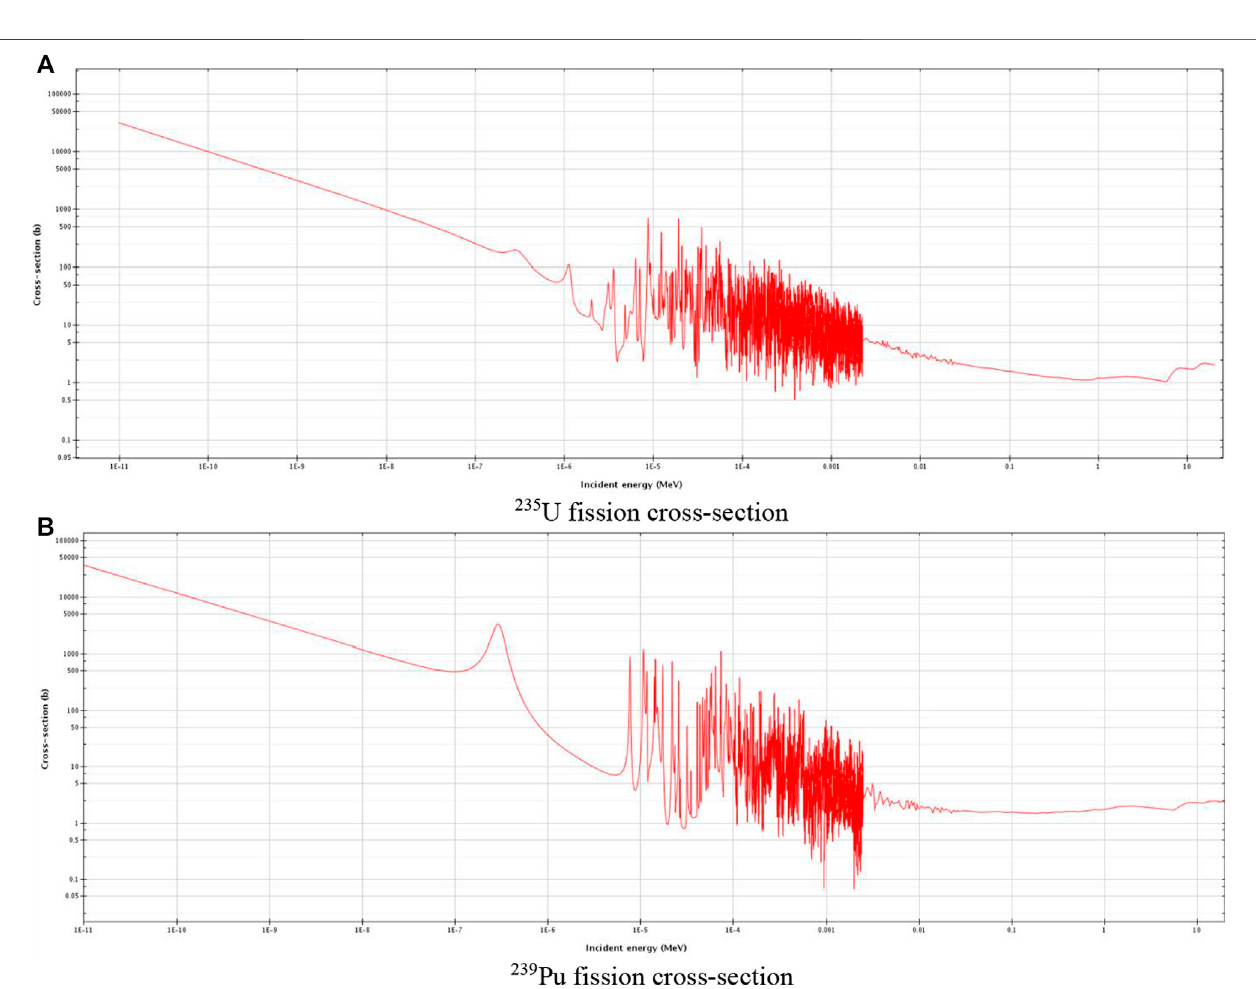
Frontiers in Energy Research |